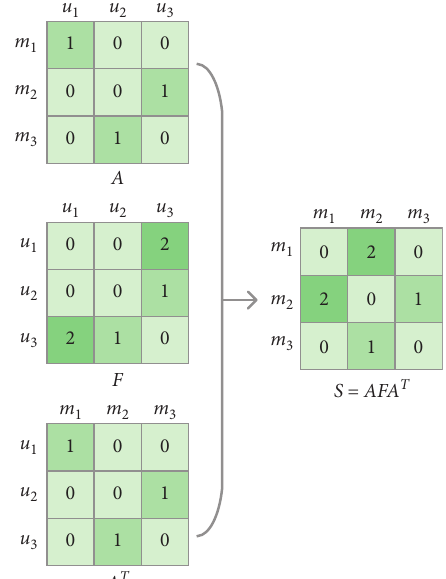
Figure 2: An example of calculating the tie strength matrix be- tween